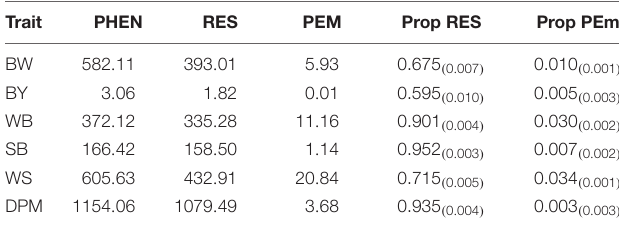
TABLE 6 | Phenotypic (PHEN), residual (RES), maternal permanent environmental (PEm) variances and proportions of phenotypic variance accounted for by RES (Prop RES) and PEm (Prop PEm) for body weight (BW), breast yield (BY), deep pectoral myopathy (DPM), wooden breast (WB), spaghetti breast (SB) and white striping (WS) analysed in study 1.